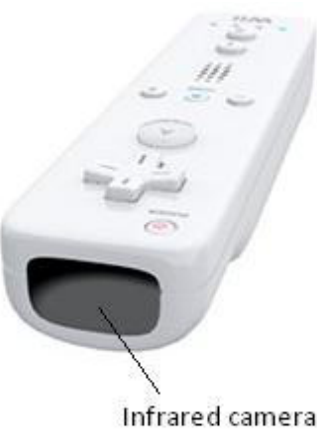
Figure 4. Regular